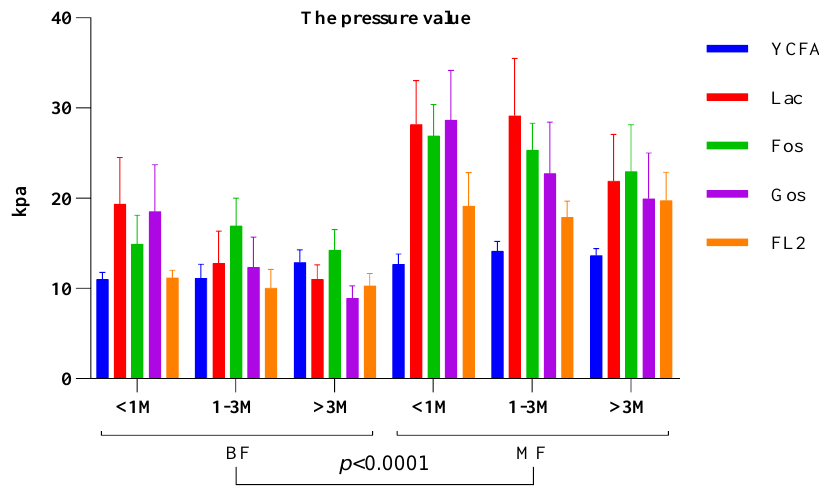
Figure 2. Comparison of in vitro simulated fermentation gas production by fecal bacteria in infants and toddlers fed differently and at different growth stages. Data were expressed as the mean ± SEM.